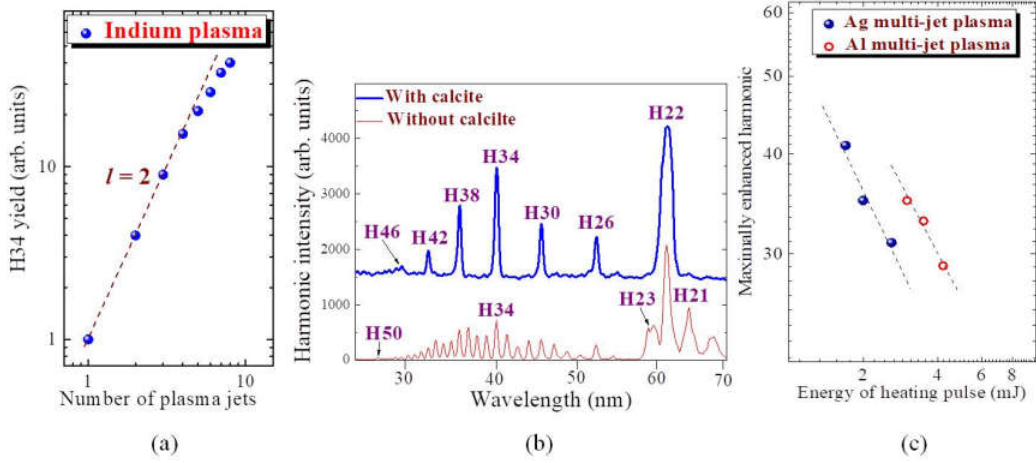
Figure 4. ( a ) Dependence of H34 intensity on the number ( n ) of jets of the indium MJP. The multi-jet indium LPP was produced using the tilted MSM with the single plasma jet sizes of 0.23 mm and pumped by two-color near infrared (NIR) + visible (1320 nm + 660 nm), 70 fs pulses. The peak intensity of 1320 nm pump was 1.4 × 10 14 W cm − 2 . The dashed line shows the slope l = 2 of the experimental dependence up to n = 4. ( b ) Harmonic distribution obtained from indium MJP in the case of propagation of driving pulses (1360 nm + 680 nm) through the plasma [bottom spectrum, similarly to the case shown in the upper panel of Figure 2b] and calcium quarter-wavelength plate and plasma (upper panel, see text). ( c ) Influence of heating pulse energy on the maximally enhanced harmonic in the case of silver (filled spheres) and aluminum (empty circles) MJPs.